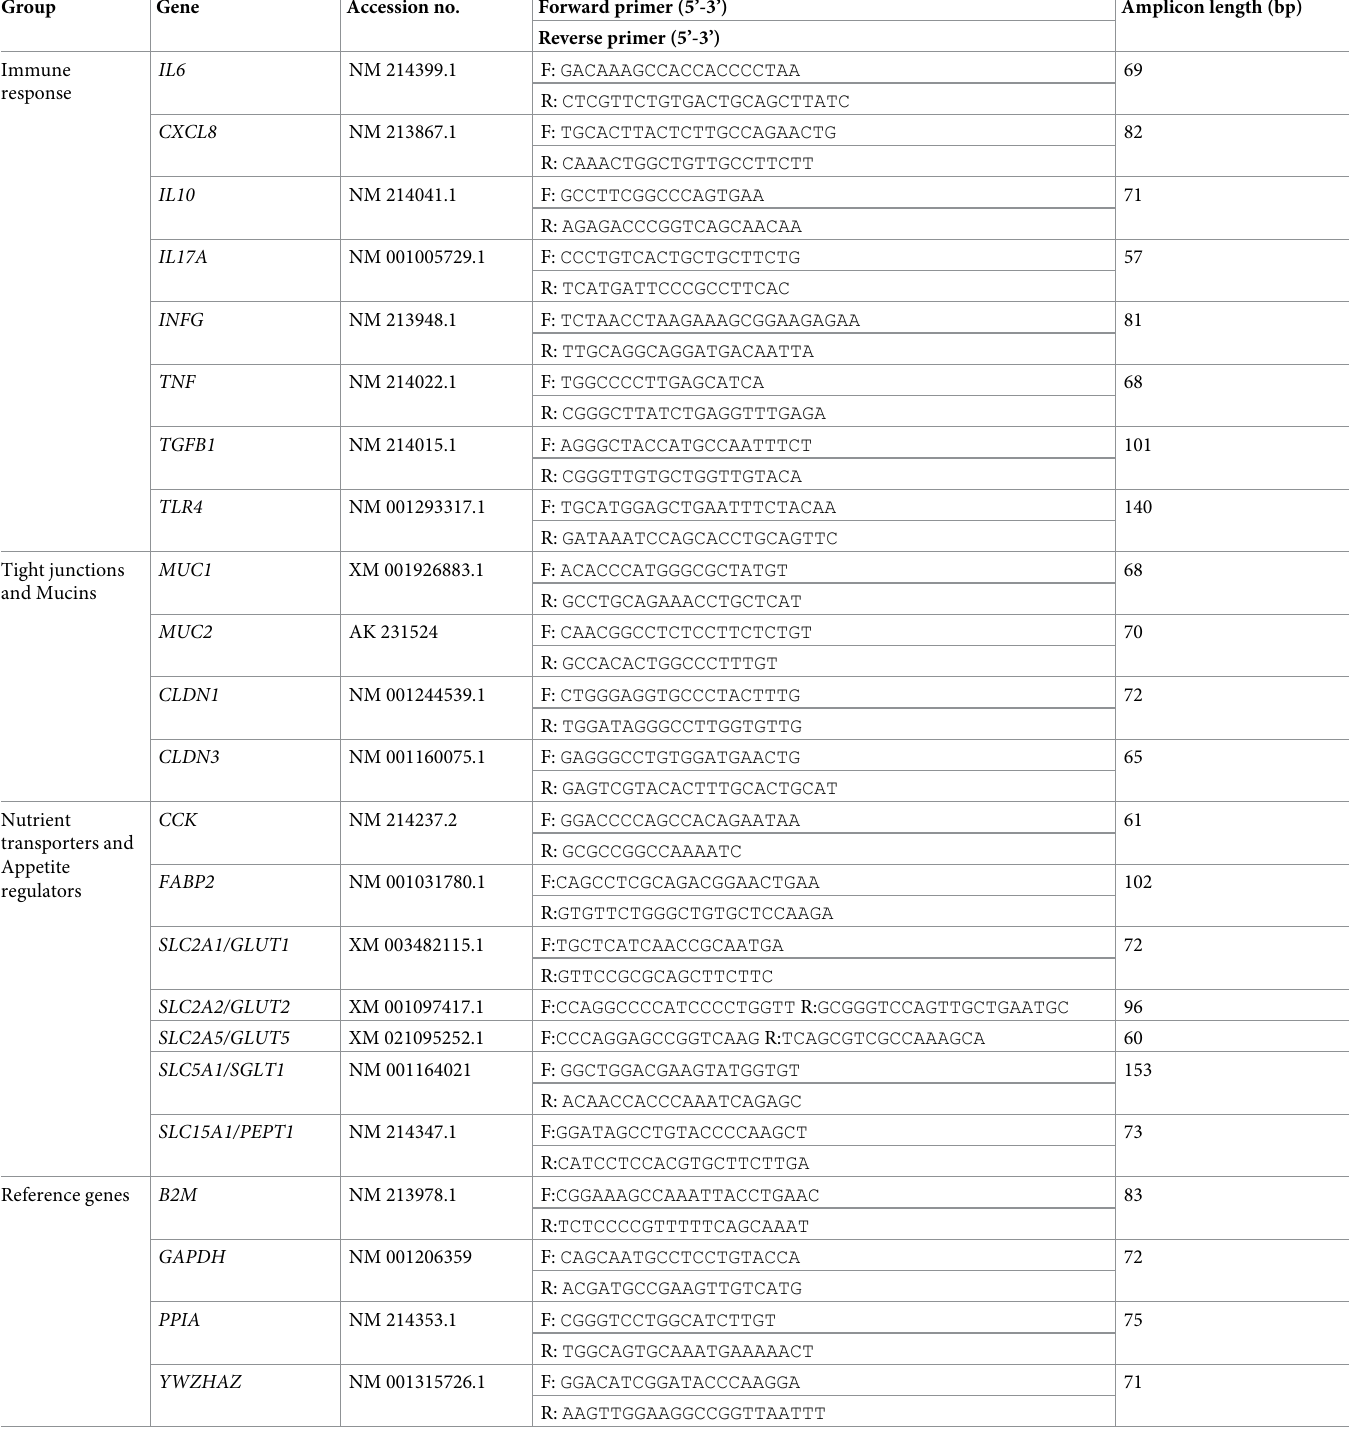
Table 2. Panel of porcine oligonucleotide primers used for real-time